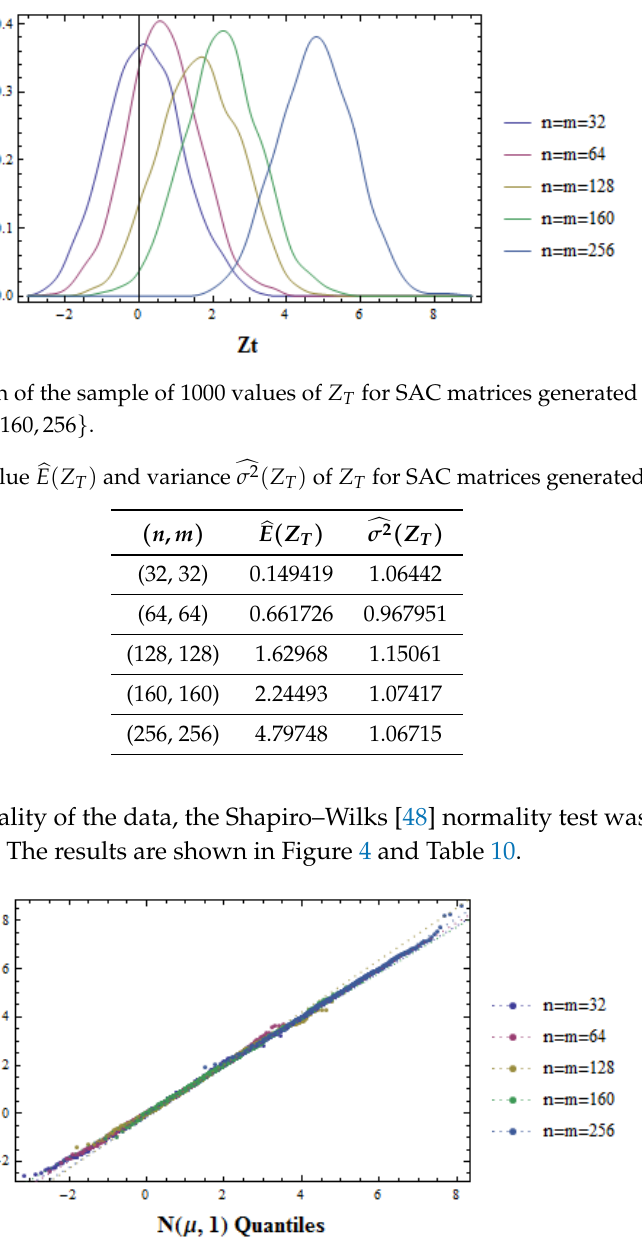
Figure 4. Normality test of the sample of 1000 values of Z T for SAC matrices generated with the RC4 with n = m ∈ { 32,64,128,160,256 } . Table 10. p -values of the Shapiro-Wilk test of normality on samples of Z t for SAC matrices generated with the RC4 with n = m ∈ { 32,64,128,160,256 }